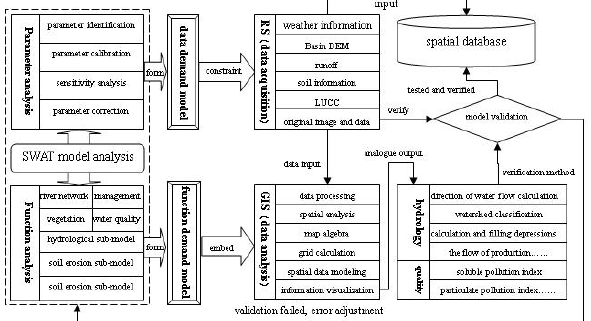
Figure 4. The Principle and Method for SWAT-Based Hydrological Modeling by Using GIS and Remote